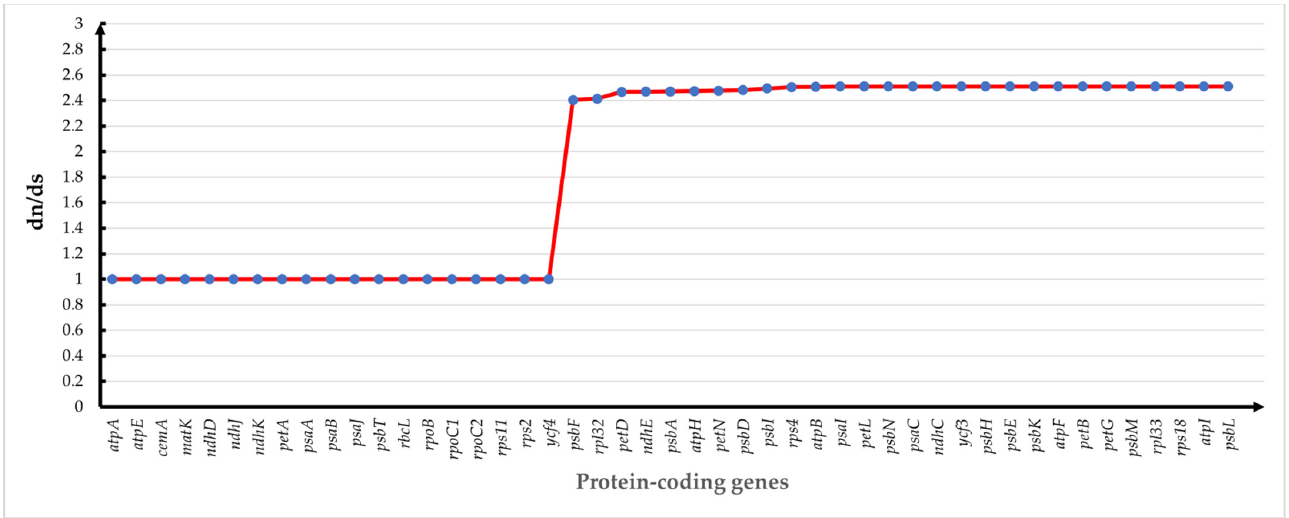
Figure 10. Phylogenetic relationship of 22 species inferred from maximum likelihood ( ML ) . ML tree constructed based on 19 protein-coding genes (CDS) and the species E. fortunei is marked in red.